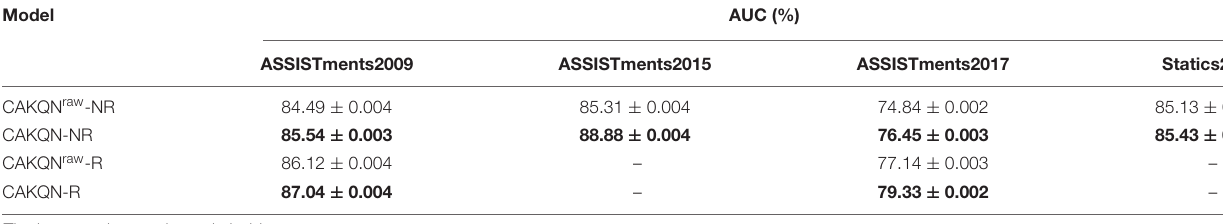
TABLE 3 | Experimental comparison between CAKQN and variant that do not use contextual aware question and response representations. Model